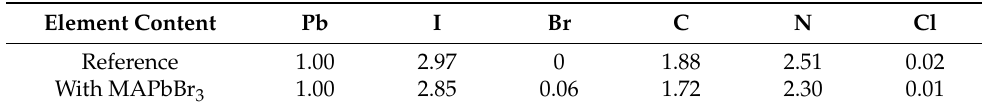
Table 1. Proportions of elements on the film surface of the reference and target samples, where the proportions of each element are relative to the content of Pb atoms.